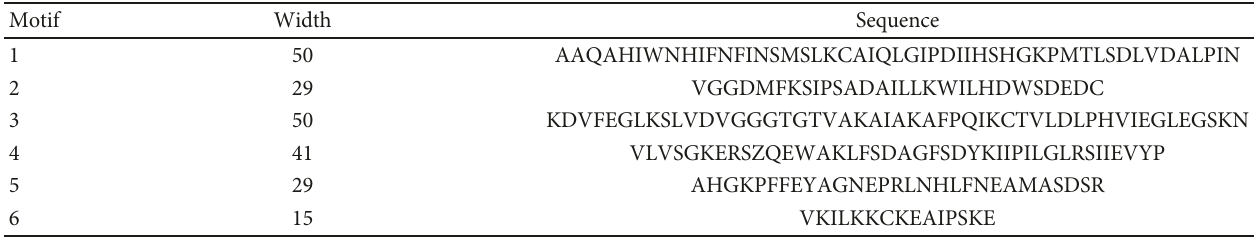
Figure 3: Conserved motif analysis of CaASMT proteins. The characteristic of the putative motifs in CaASMT proteins. Di ff erent color boxes represent various types of conserved motifs. Table 2: Conserved motifs of CaASMT genes in pepper.